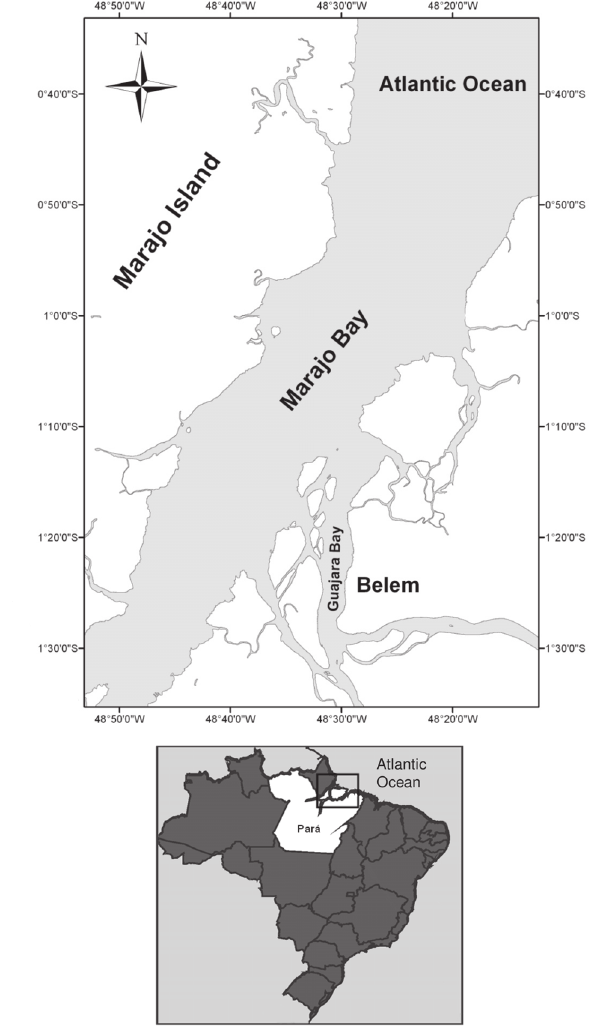
Fig. 1. Study area. Bay of Marajo in the Amazon Estuary,